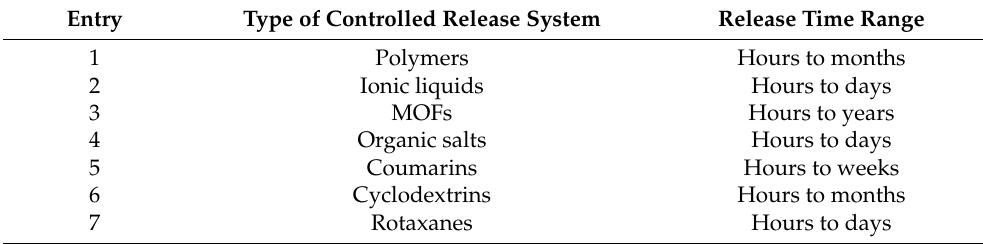
Table 2. Range of release times of scents provided by the different controlled release